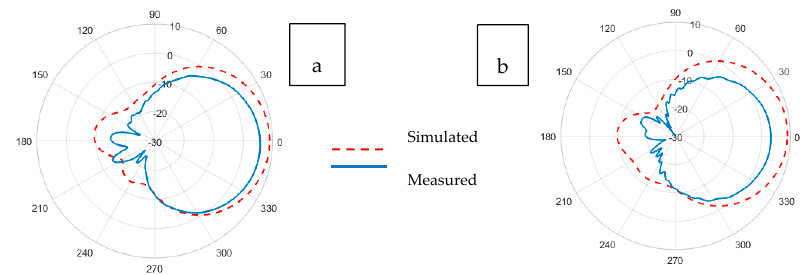
Figure 11. Simulated and experimental ( a ) E-plane and ( b ) H-plane radiation patterns of Prag-based non-perforated RRMPA at 2.45 GHz.